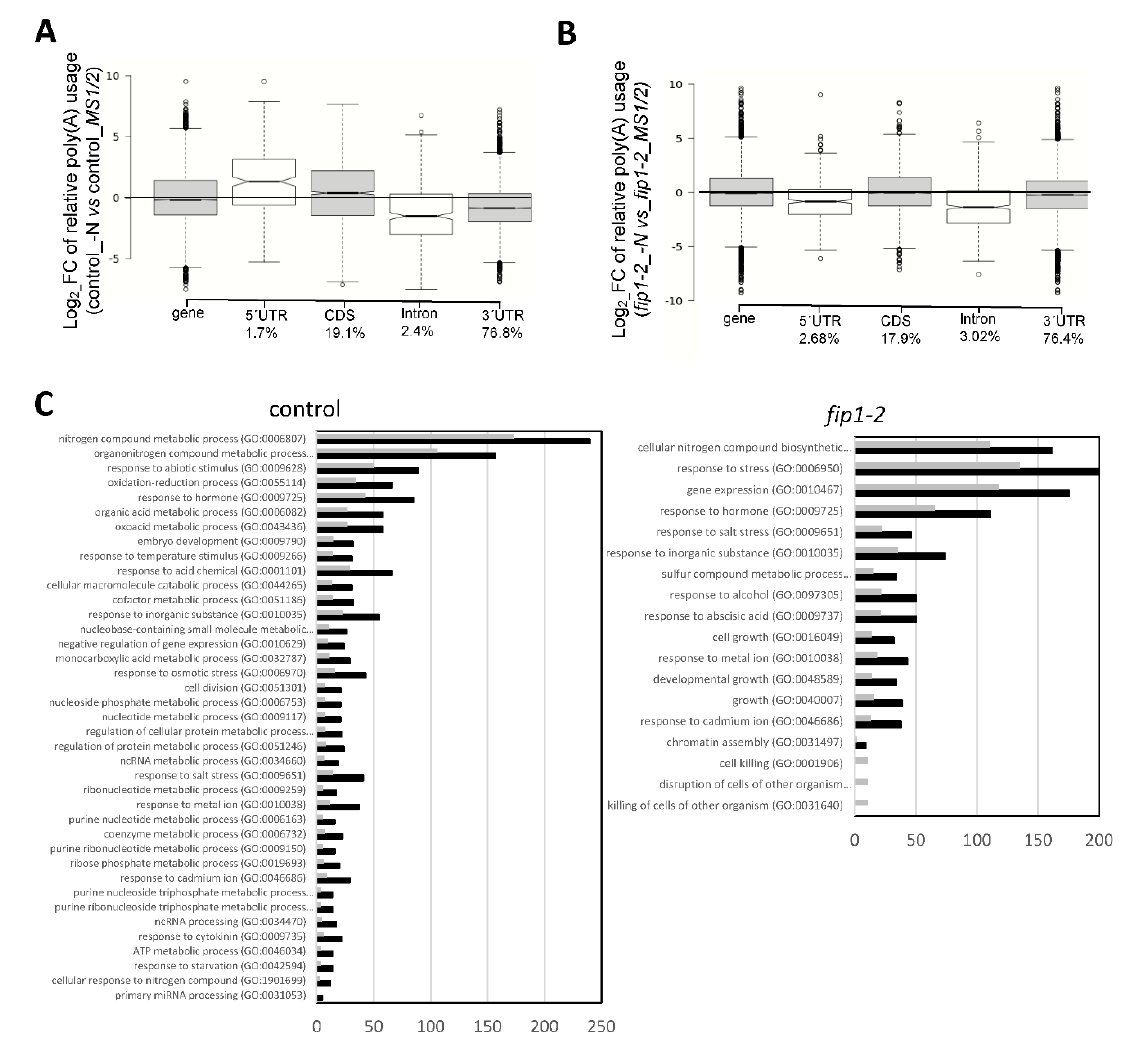
Figure 2. Genome-wide distribution of poly(A) site usage in response to nitrogen starvation and mediated by FIP1. Box plots showing change in usage of different classes of poly(A) sites. For this, the relative contribution that each poly(A) cluster (PAC) makes to total poly(A) usage was determined on a gene-by-gene basis, with the ratios of usage in nitrogen starved roots in control seedlings ( A ) or in fip1-2 ( B ) calculated and log2-transformed. “Gene” represents the complete collection of PACs analyzed. Bottom percentage indicates the relative number of PACs in each locus position. ( C ) Gene ontology analyses of genes showing APA in control or fip1-2 in response to N deficiency in roots with FDR < 0.05 and a fold enrichment > 2. Grey bars correspond to expected number of genes and black bars to observe number. For full list of GO categories, see Table S1.